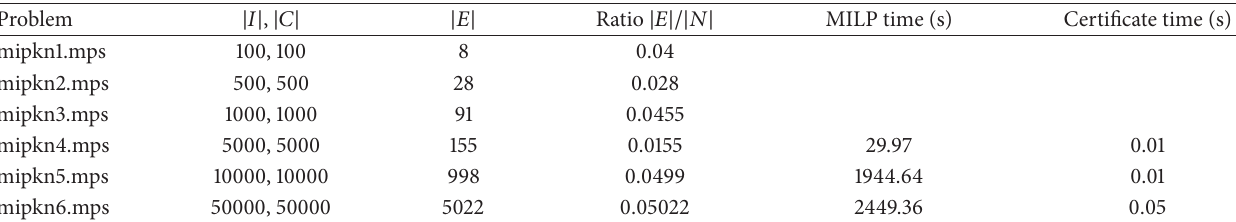
Table 2: Mixed integer knapsack problems with nonnegative